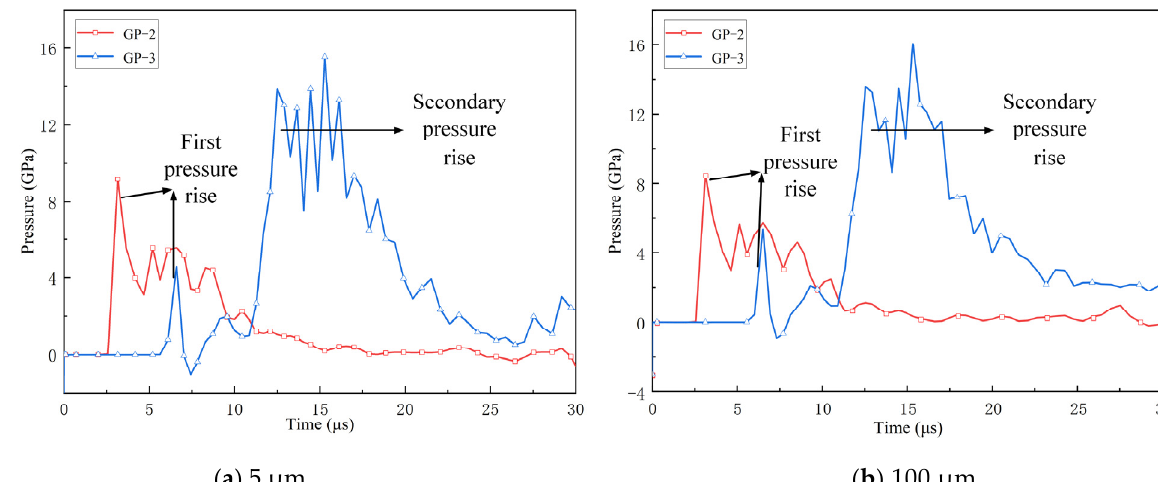
Figure 10. Gauss point pressure curve.